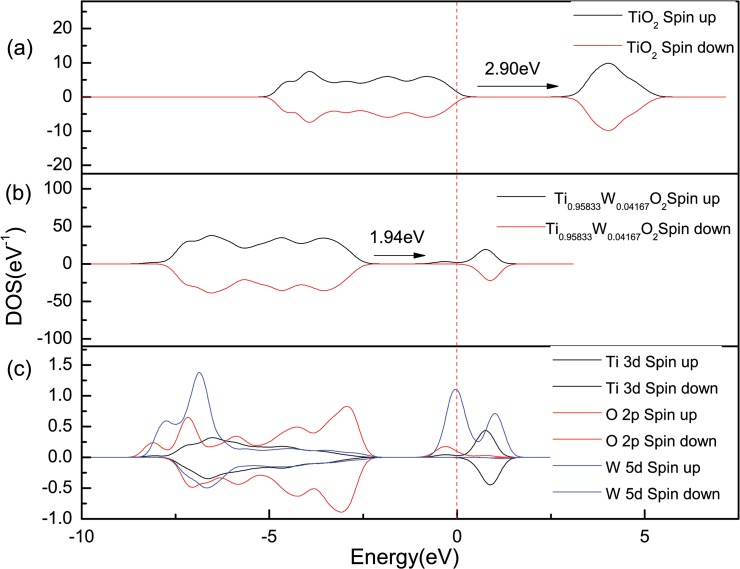
Density of states for pure and W-doped anatase TiO2 under the condition of spin.(A) Total density of state for pure anatase TiO2 unit cell, (B) Total density of state for Ti0.95833W0.04167O2 supercell, (C) Partial density of state for Ti0.95833W0.04167O2 supercell.